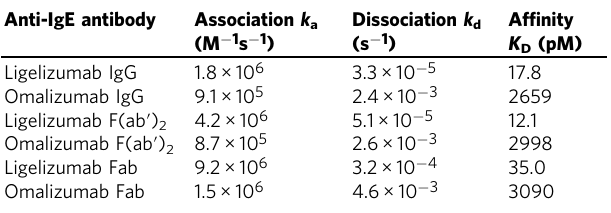
Table 1 Binding kinetics of ligelizumab and omalizumab variants for human